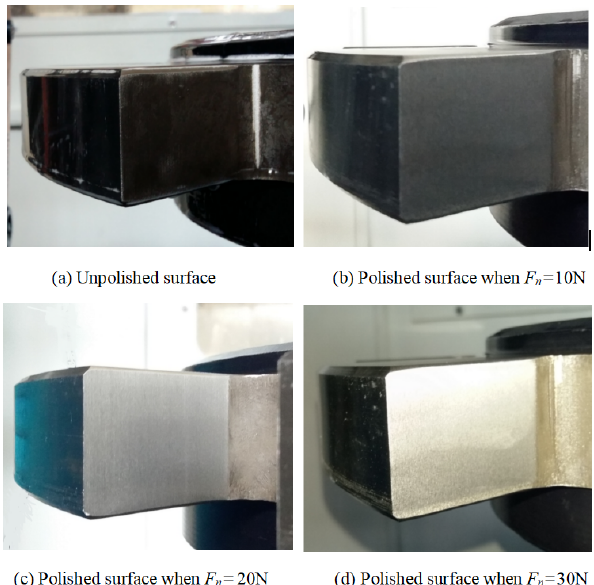
Figure 15. Surface conditions before and after polishing with dif- ferent polishing